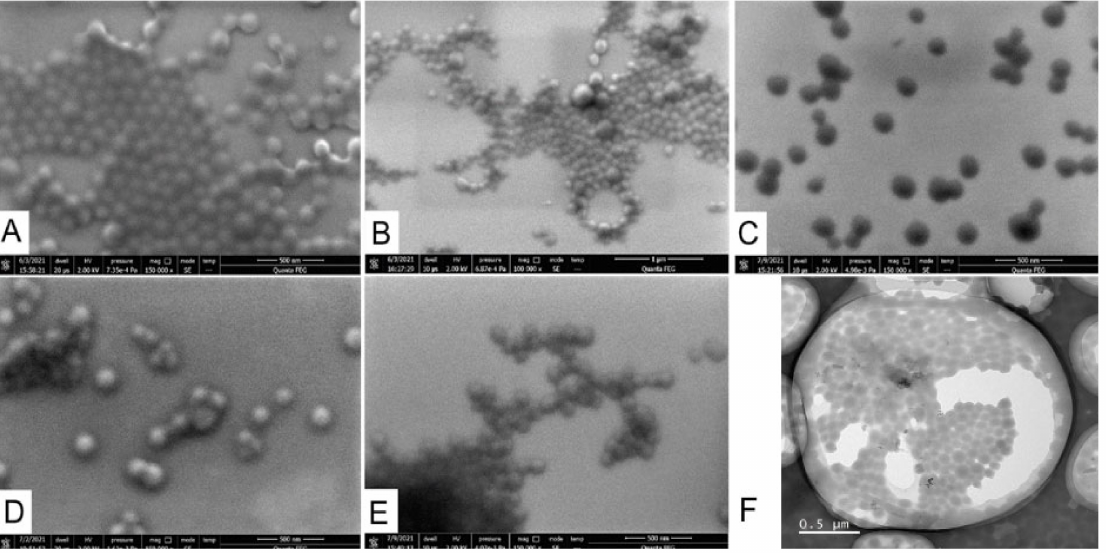
Figure 5. SEM ( A – E ) and TEM ( F ) images of gelatin nanoparticles. ( A , F ) B75-1; ( B ) B225-1; ( C ) FISH-1; ( D ) A62-1; ( E ) A180-1. Scale bars are 500 nm ( A , C – F ) or 1000 nm ( B